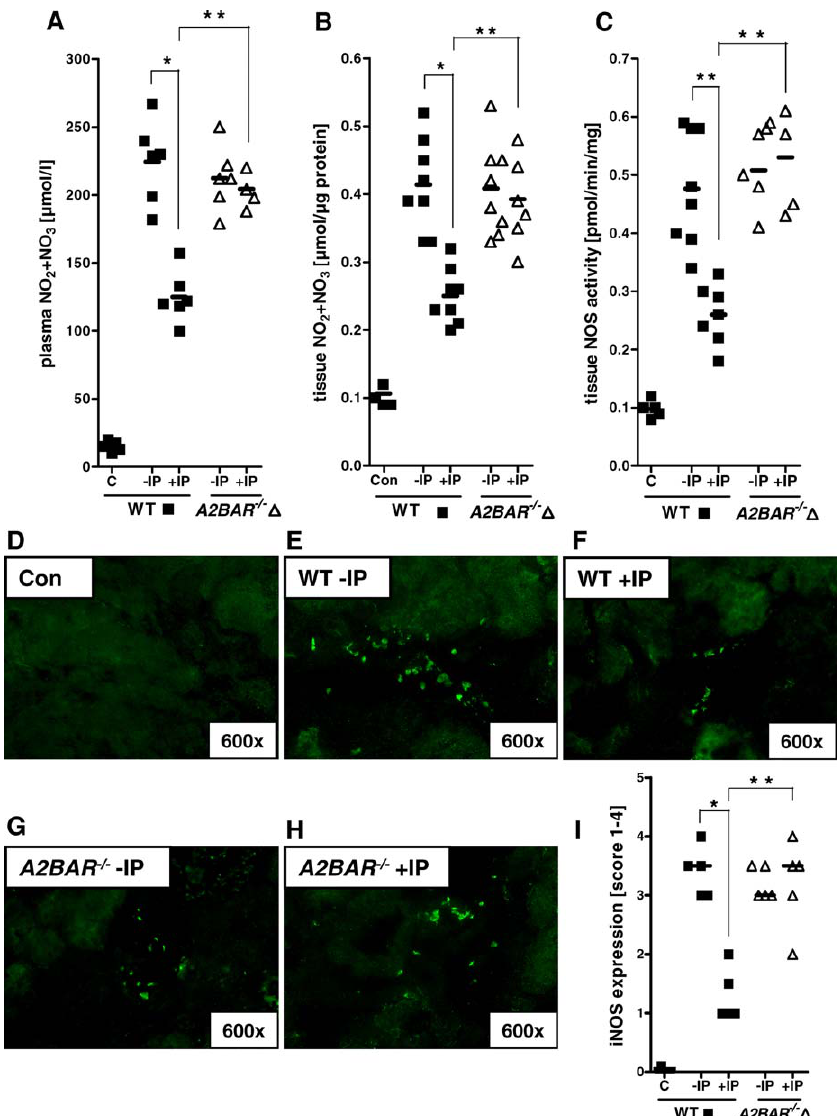
Figure 6. Nitrite, Nitrate Plasma Concentrations, and Renal Tissue Content and Nitric Oxide Synthetase Activity in Renal Tissues A2BAR (cid:2) / (cid:2) mice and their respective age-, weight-, and gender-matched littermate controls (WT) were subjected to right nephrectomy followed by 45 min of left renal artery ischemia with or without prior in situ IP (consisting of four cycles of 4 min ischemia followed by 4 min reperfusion). (A) Plasma or (B) tissue concentrations of nitrite (NO 2 ) and nitrate (NO 3 ) were measured using colorimetric-assay kits. (C) Tissue nitric oxide synthetase (NOS) activity. (D–H) Immunohistochemical staining for iNOS. (I) iNOS expression score. Statistics: (A–C) One-way ANOVA with Tukey’s post-hoc test was performed (*, p , 0.001 versus WT þ IP; **, p , 0.001 versus the A2BAR (cid:2) / (cid:2) mice with IP). The F -test results are (A) F (4,22) ¼ 89.90, p , 0.001; (B) F (4,30) ¼ 32.41, p , 0.001; (C) F (4,25) ¼ 36.54, p ,